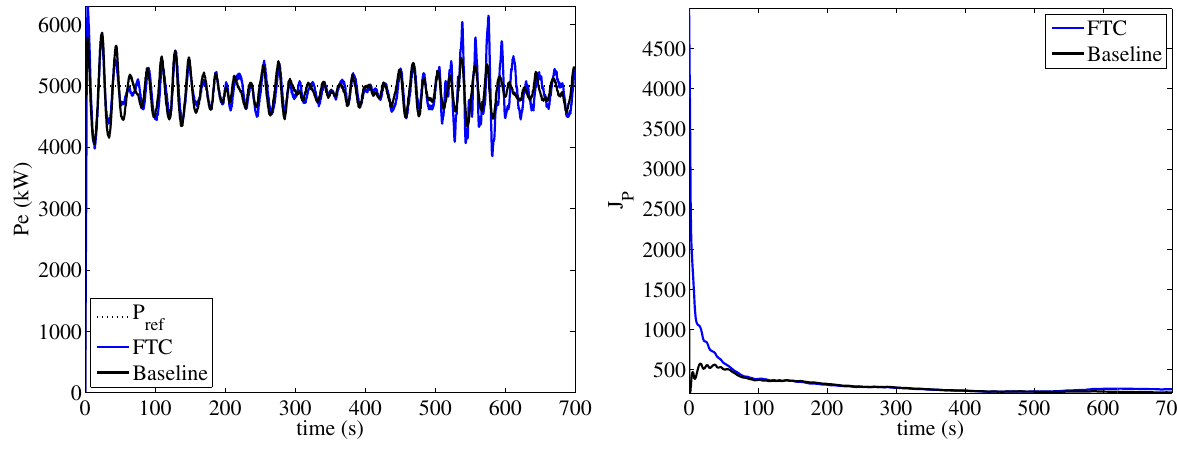
Figure 5. Electrical power ( left ) and J